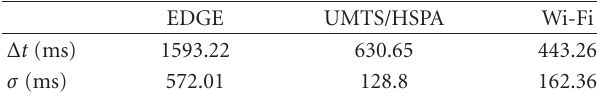
Table 3: Time needed for position